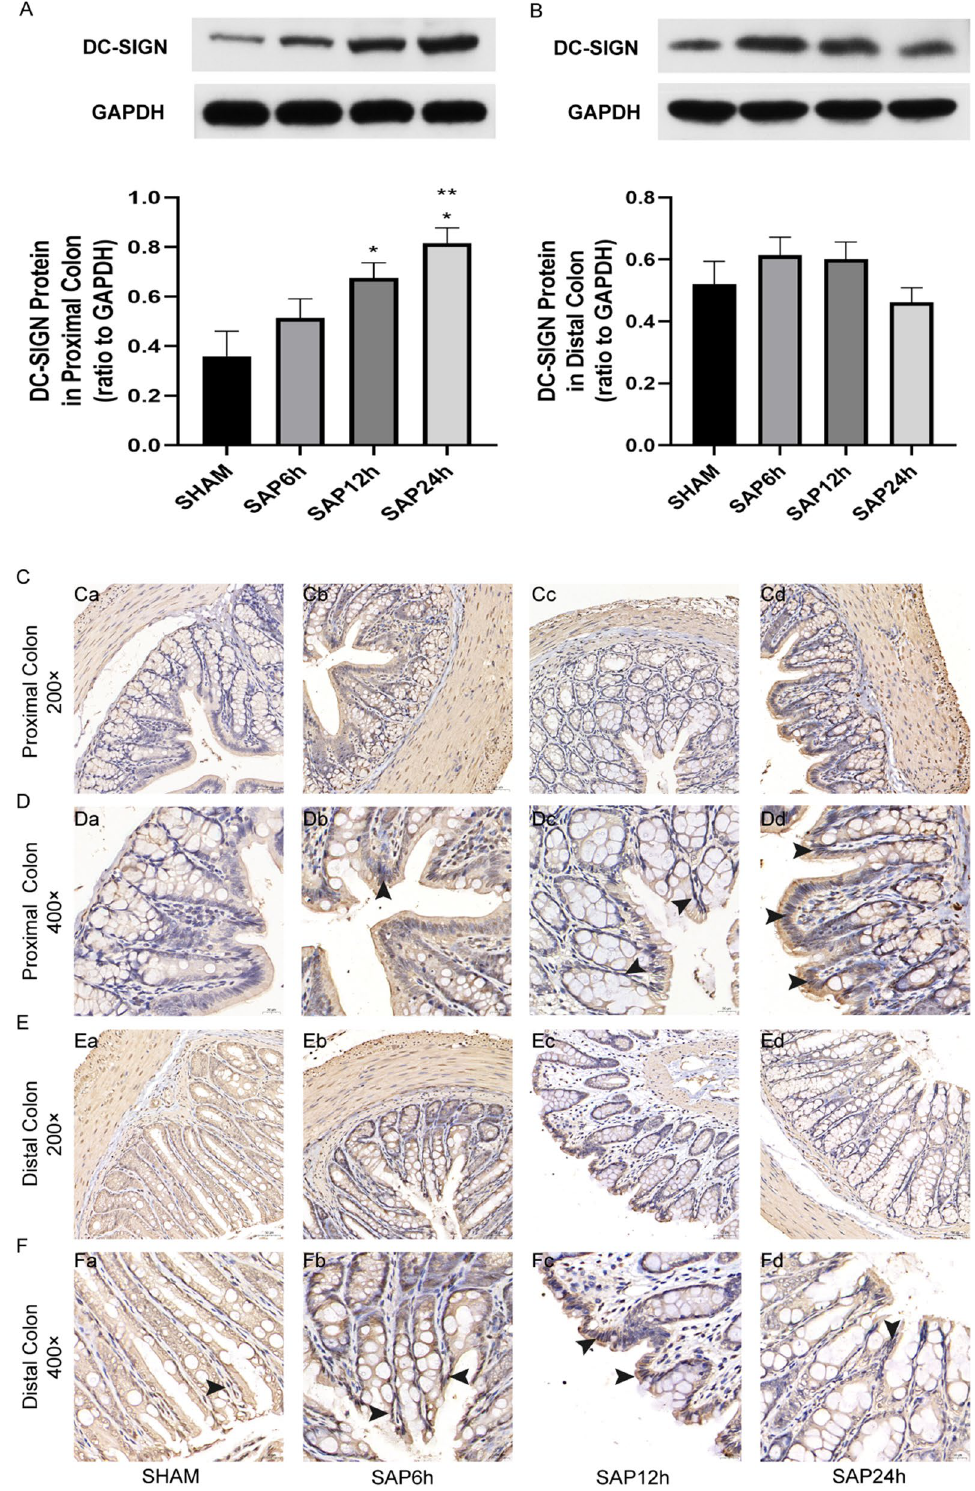
Figure 1. DC-SIGN expression in the proximal and distal colons of SAP rats at 6, 12, and 24 h. ( A ) Western blot analysis of DC-SIGN expression in the proximal colon. ( B ) Western blot analysis of DC-SIGN expression in the distal colon. ( C , D ) Immunohistochemical staining of DC-SIGN expression in the proximal colon. ( E , F ) Immunohistochemical staining of DC-SIGN expression in the distal colon. * p < 0.05 compared to SHAM, ** p < 0.05 compared to